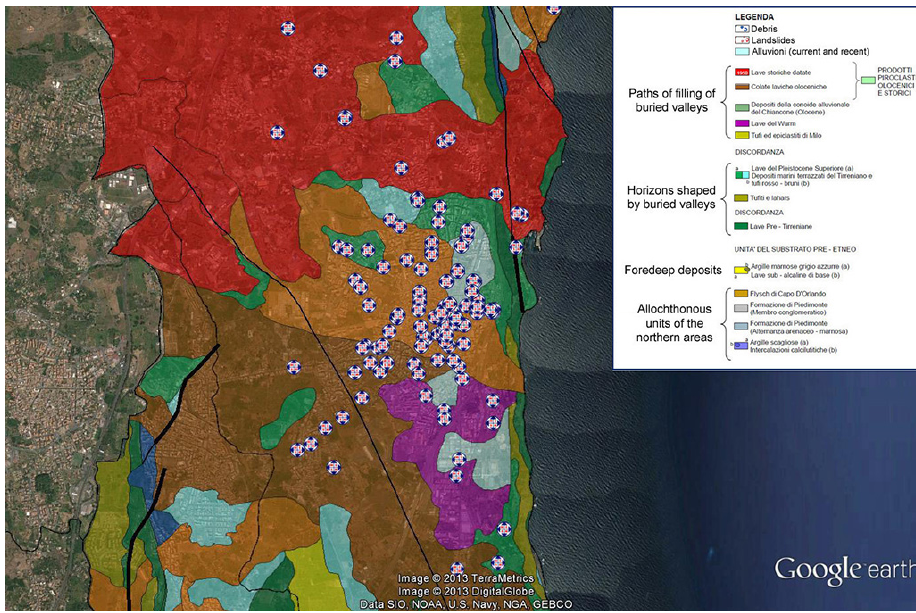
Figure 2. Geological map of Acireale and surrounding (Azzaro et al., 2010) with located more than 200 candidate sites identified among historical buildings and schools with high seismic vulnerability and exposure.